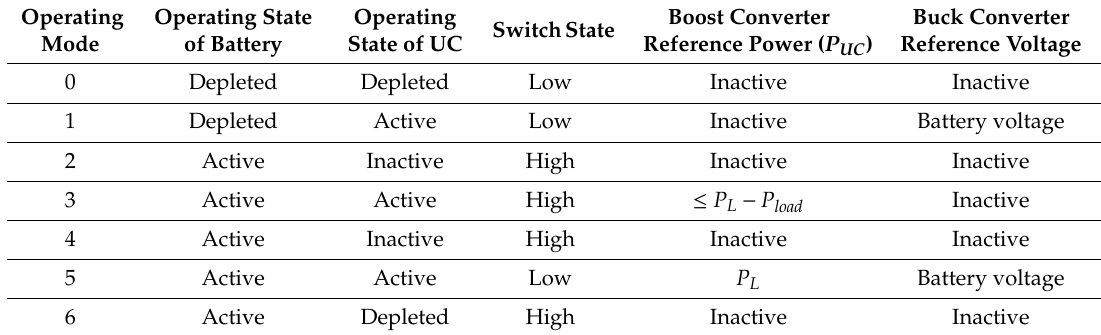
Table 1. Hybrid energy storage system (HESS) operating